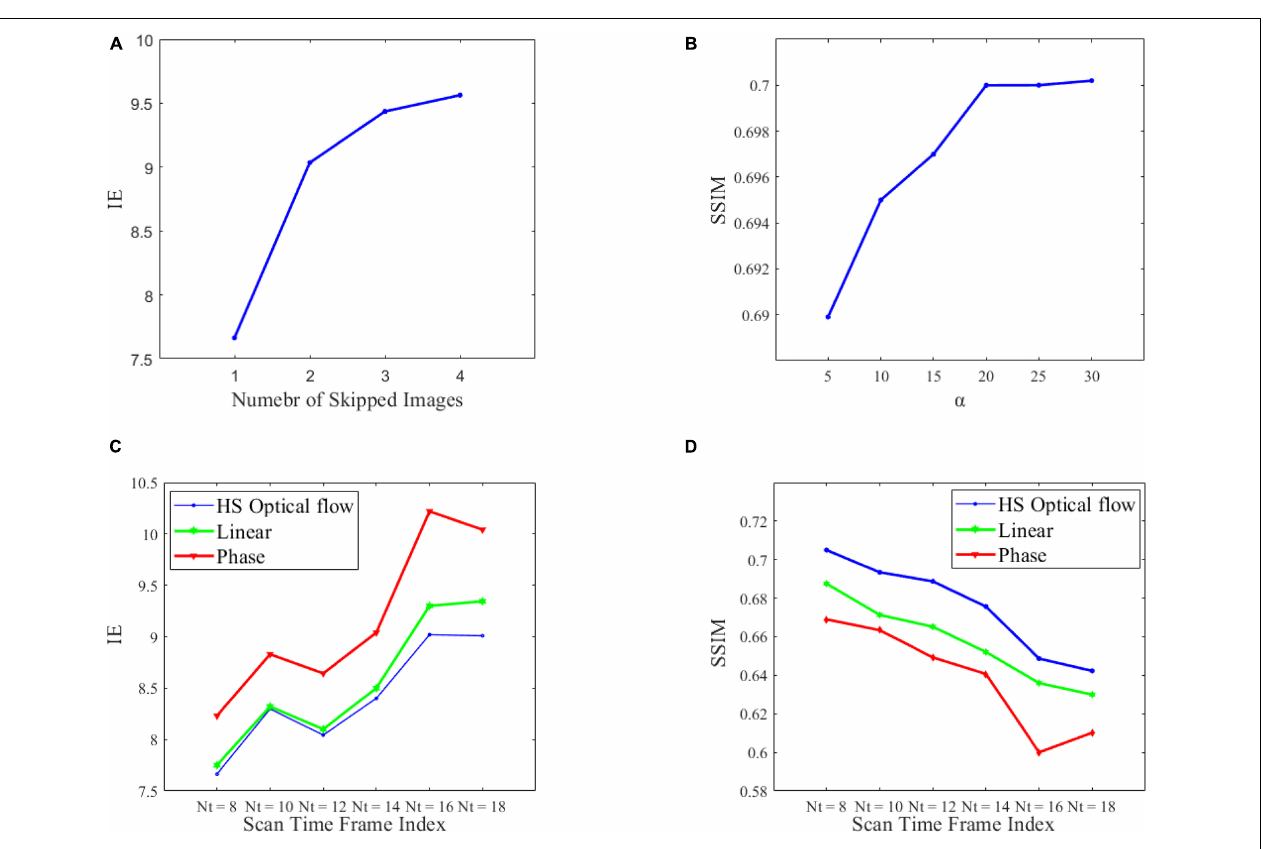
FIGURE 4 | Performance of the proposed algorithm. (A) Quality of interpolated PC-MRI vs. the number of skipped images. (B) The influence of parameter α on SSIM. (C,D) IE and SSIM performances during the selected time frame indices for optical flow interpolation, phase-based interpolation, and linear interpolation, to deal with the construction of the intermediate